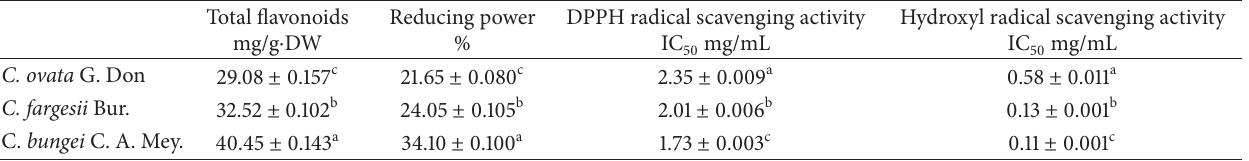
Table 1: The total flavonoid contents and antioxidant activity of crude extracts from the leaves of Catalpa plants.